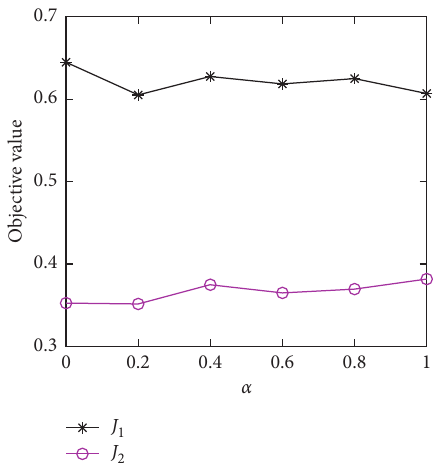
1 and J 2 with different α